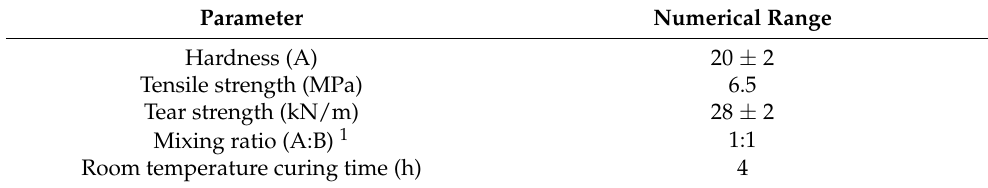
Table 1. E60 Silicone performance parameter table.